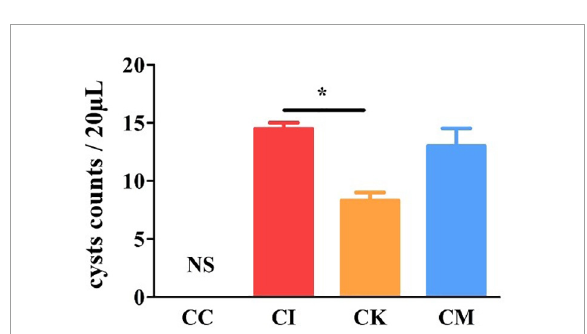
FIGURE6 The brain cyst count in mice with chronic T. gondii infection at 42 dpi. CC: no T. gondii + PBS; CI: 3 T. gondii cysts + PBS; CK: 3 T. gondii cysts + koumiss; CM: 3 T. gondii cysts + mare’s milk. All data are expressed as mean ± SD. * P < 0.05 and N.S., no